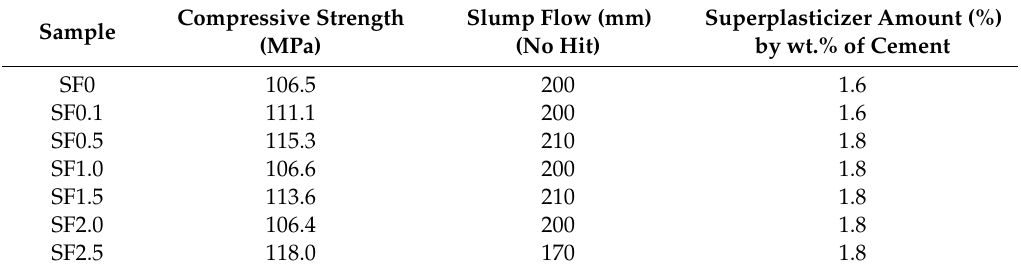
Table 4. Flow and compressive strength of samples with various amounts of superplasticizer.